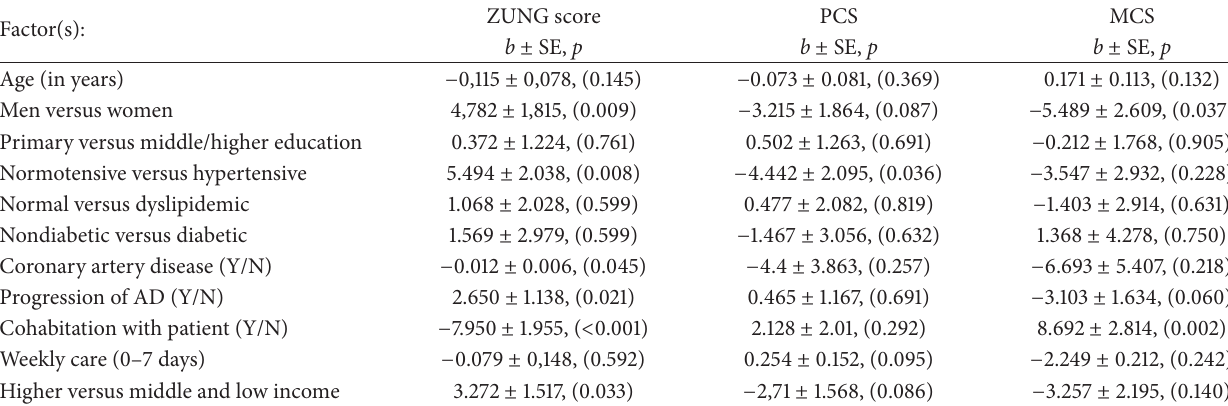
Table 4: Results from multiple linear regression models that evaluated sociodemographics, financial status, chronic diseases, habitation conditions, aggravation of illness, kinship, and weekly care.